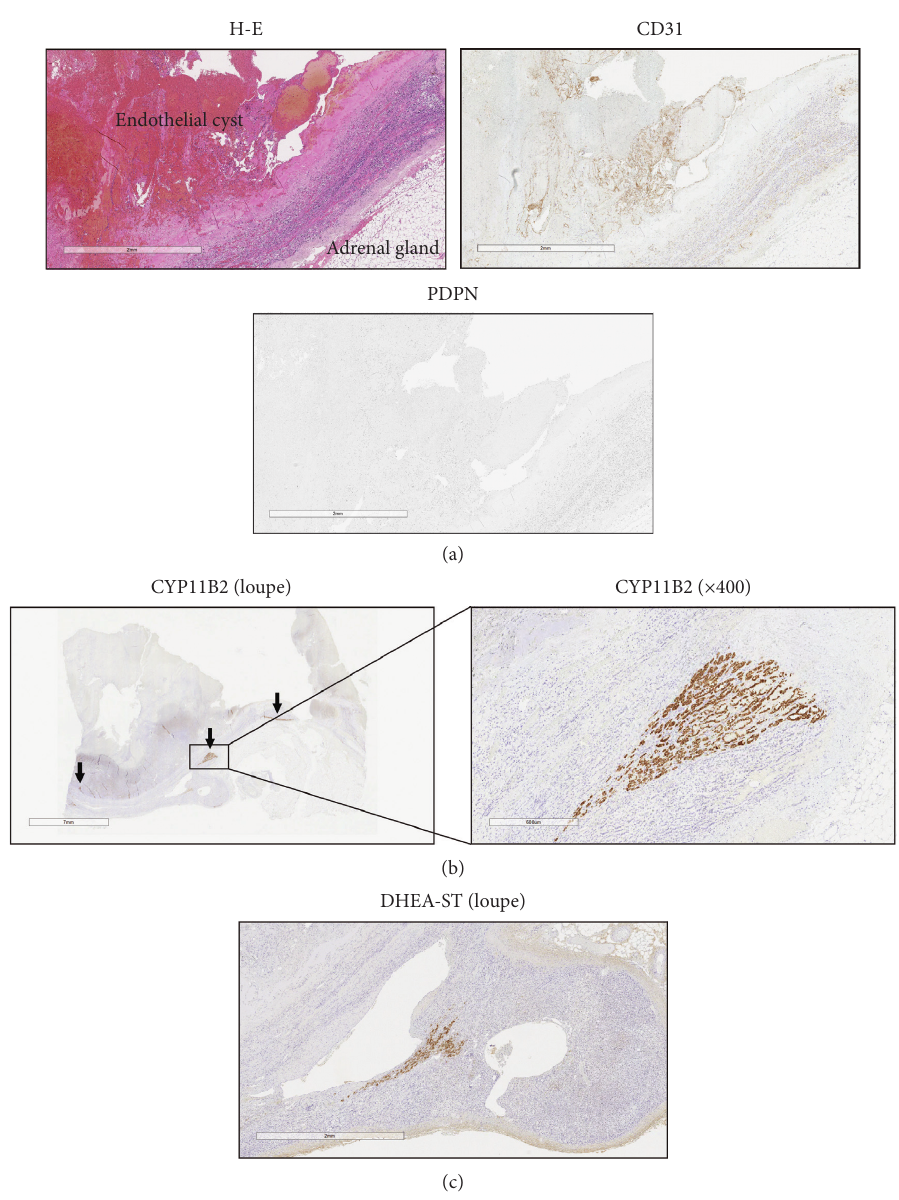
Figure 3: (a) H-E staining (H-E) immunostaining with anti-CD31 antibody (CD31) or anti-PDPN (D2-40) antibody (PDPN) of the resected tumor (magnification: x200). (b) Immunostaining of the resected tumor with anti-CD11B2 antibody. Left: loupe, right: x400 magnification. Arrow: CYP11B2-positive regions. (c) Immunostaining with anti-DHEA-ST antibody of the adjacent adrenal gland (magnification: